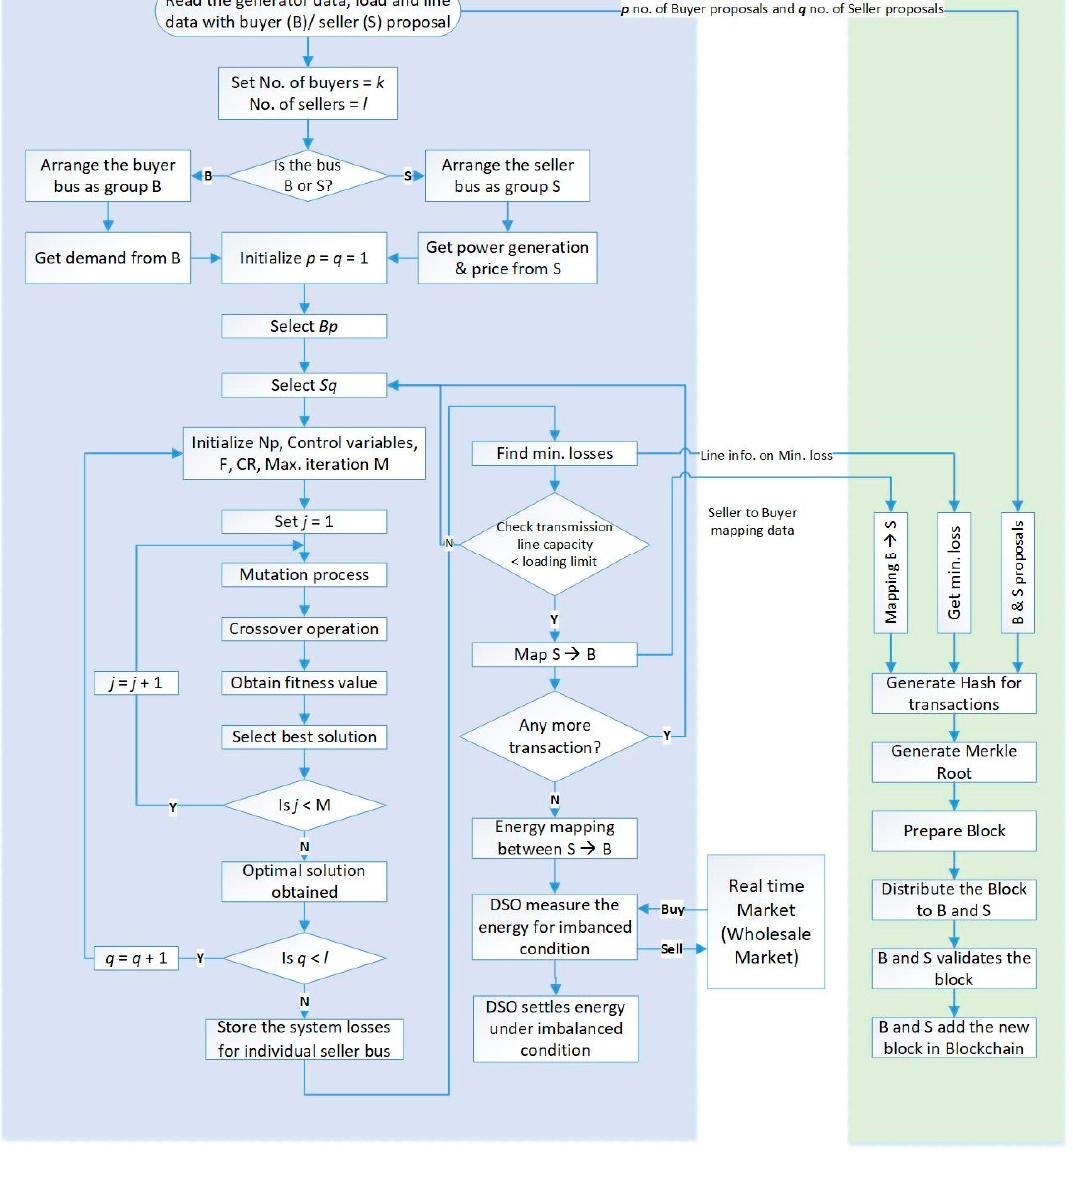
Figure 4. Overall process of energy trading using blockchain.